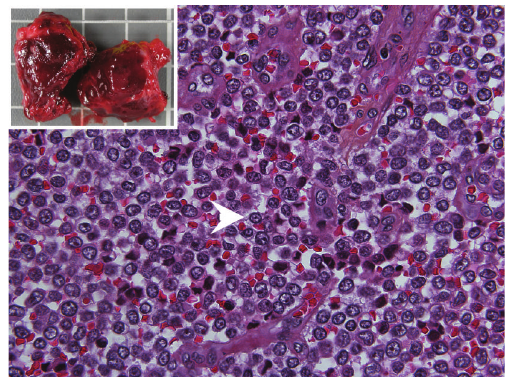
Figure 2: (Histological examination) HES × 600 small-round- blue-cell arrow head tumor with highly cellular areas. Insert (gross examination) showed a pseudoencapsulated fleshy tumor